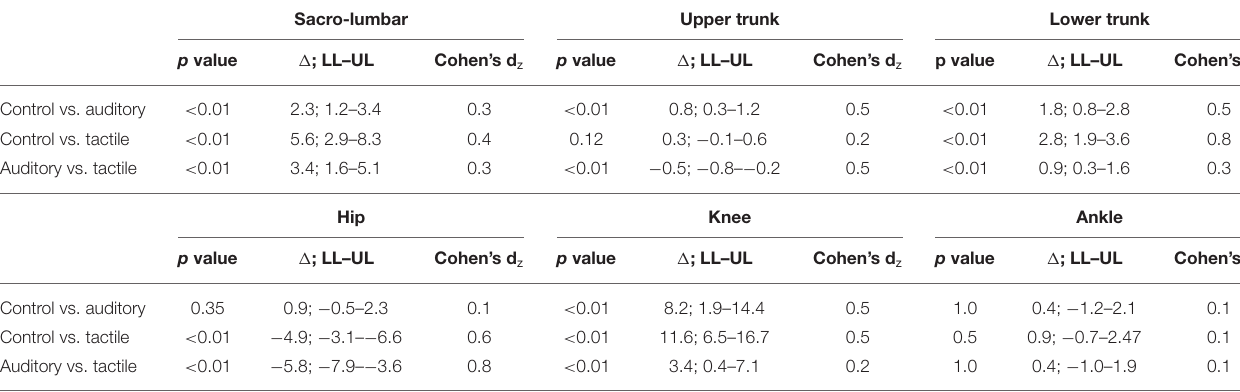
TABLE 2 | Pairwise comparisons in the acquisition